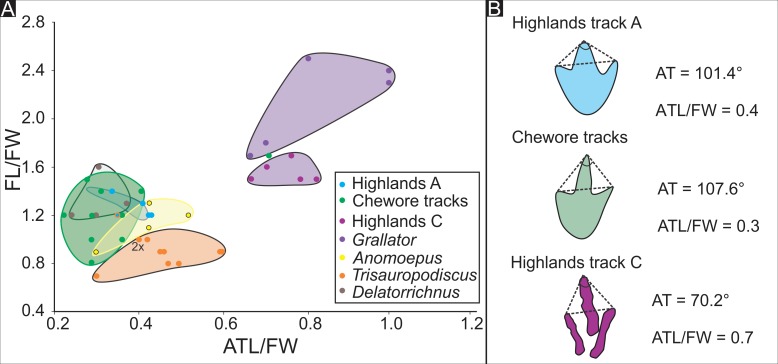
Analysis of the mesaxony of the Highlands tracks A and C as well as other selected Jurassic tridactyl tracks.(A) Bivariate plot of the footprint length to footprint width ratio (FL/FW) against the anterior angle length to footprint width ratio (ATL/FW). (B) Explanatory sketch of the measurements of AT used in (A). Data are from this study, Ellenberger [54], Lingham-Soliar and Broderick [74], Lockley [79], Dalman and Weems [80] and Abrahams et al. [81]. For raw data on the Highlands and Chewore ichnosites, see S1 Table.